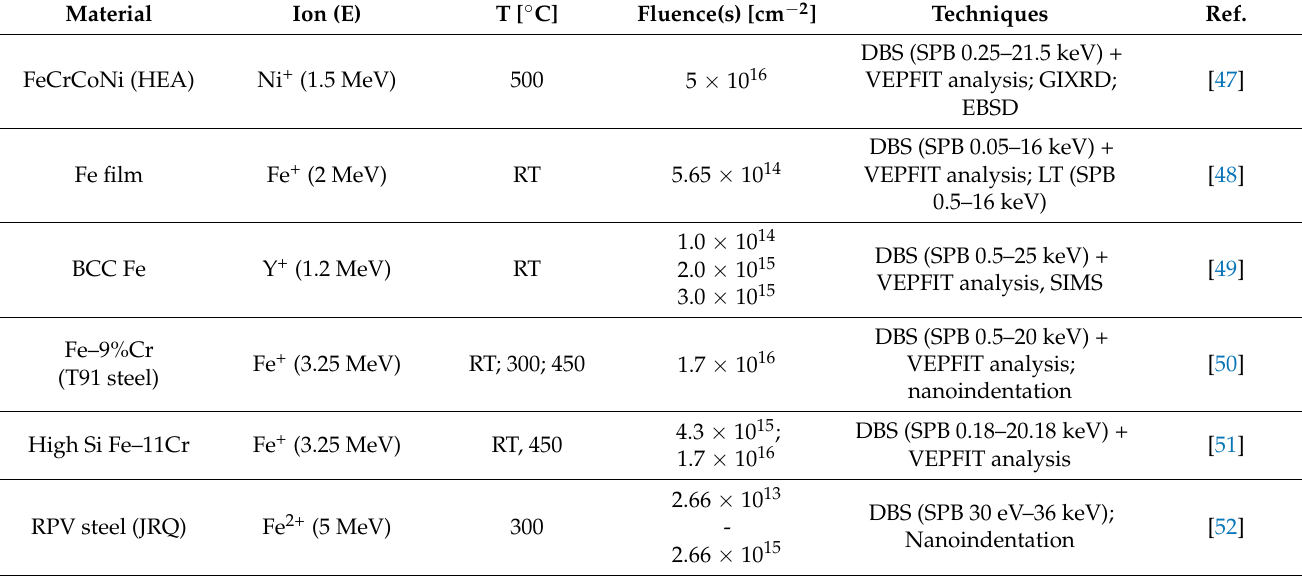
Table 1. Selected PAS studies published on self-ion irradiation of nuclear structural